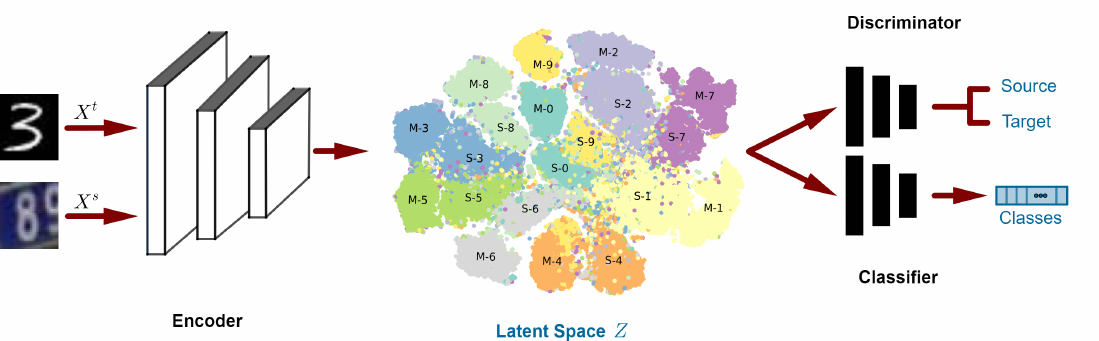
Figure 2. Architecture of our model. This can be divided into three parts: An encoder, a discriminator, and a classifier. The encoder translates the images (i.e., the X space) to embeddings in the latent space (i.e., the Z space). In the latent space, each group of embeddings is marked by either S i or M i , where i is the label of the image, and the prefix letter denotes whether it is from MNIST (M) or SVHN (S). Thus, the Z space can be expressed as Z = Z s ∪ Z t , where Z s = (cid:83) i S i and Z t = (cid:83) i M i . The latent representation is fed to both the discriminator and the classifier. The discriminator distinguishes if the latent representation is from source or target domain, whereas the classifier finds the suitable label for